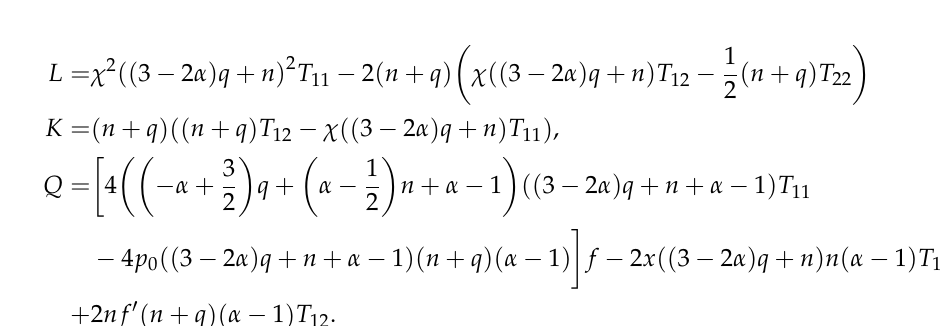
Figure 2. Solution of the upstream boundary layer with a = shown for n = 0.2,1 and 2 which are denoted by the solid, dashed, and dotted lines